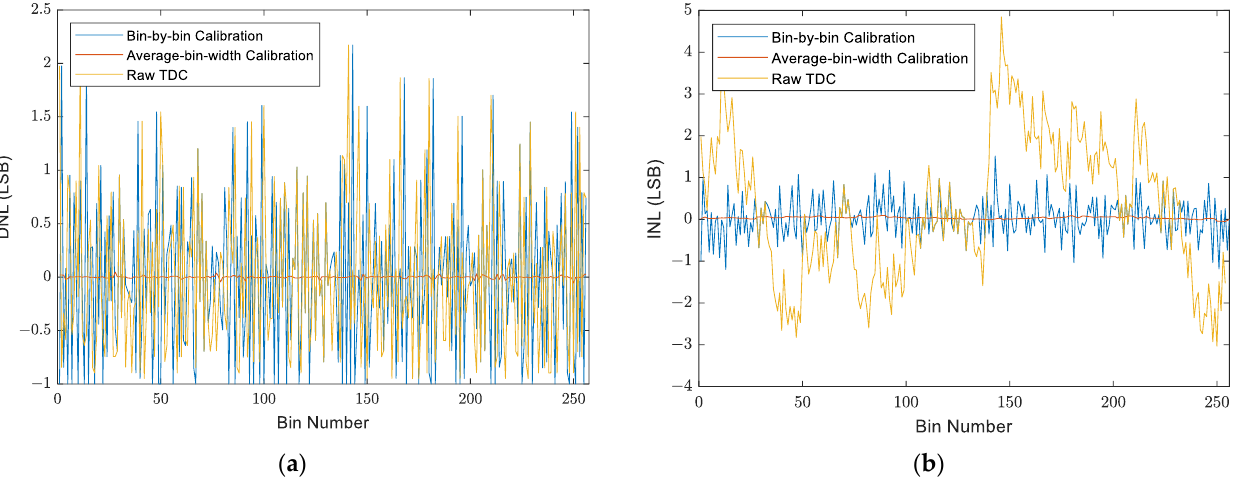
Figure 12. Simulation and experimental results for synchronous TDCs: the DNL after applying the calibration methods compared to the DNL of the raw TDC.